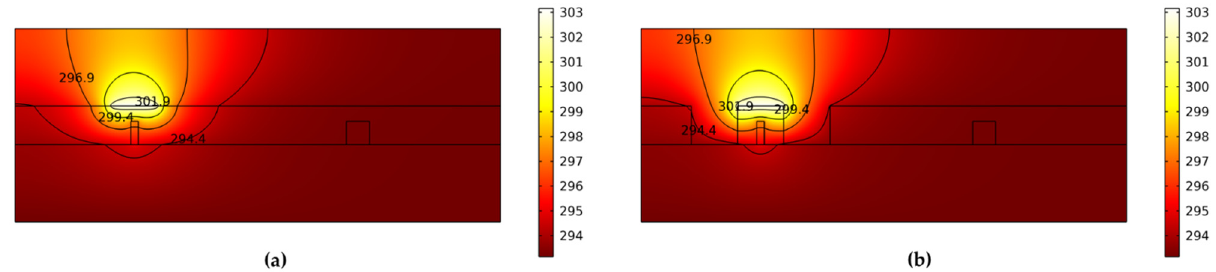
Figure 6. The cross-sectional thermal distribution of the device ( a ) without an air trench and ( b ) with an air trench.